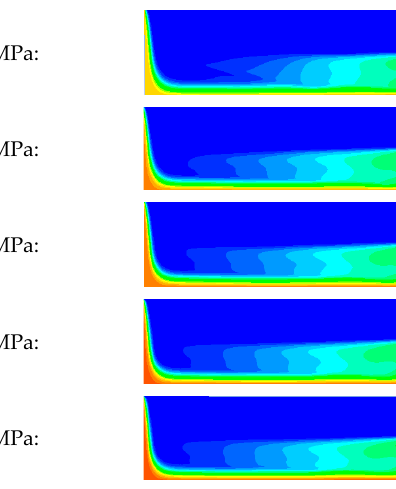
Figure 13. Gravel settlement diagram with different average pressures.